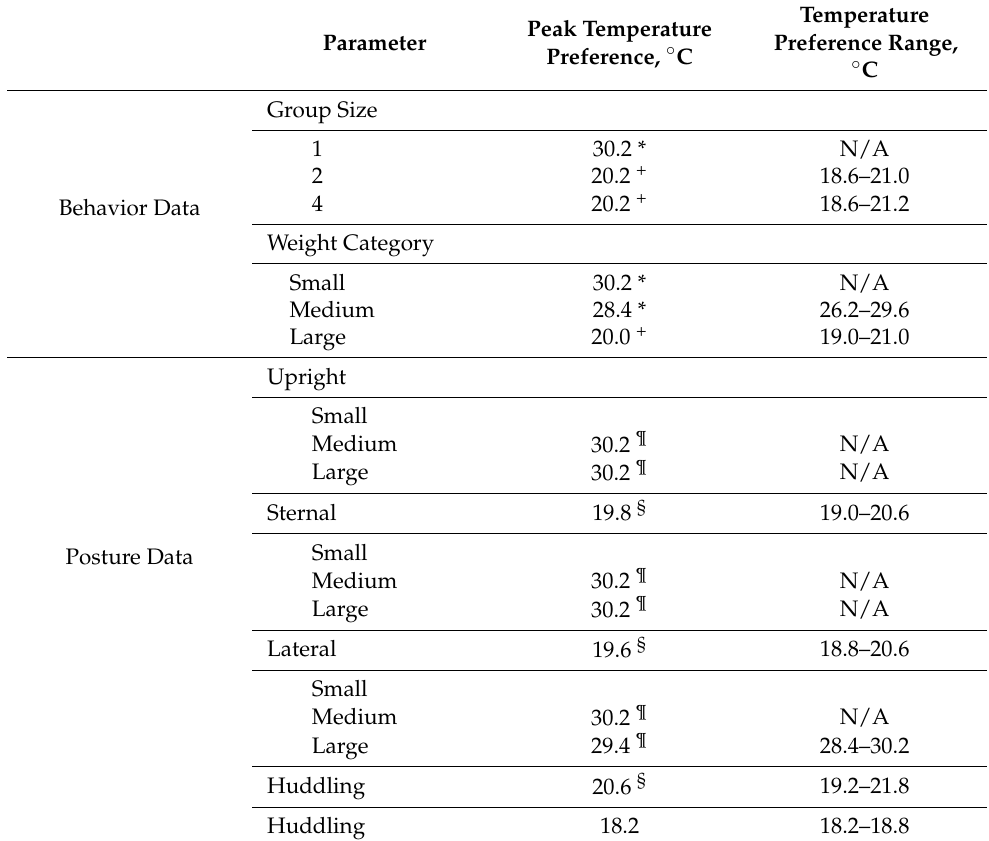
Table 2. Peak temperature preference, ◦ C, by group size and weight category for inactive behaviors and posture (LSM ± SE) based on regression formula.